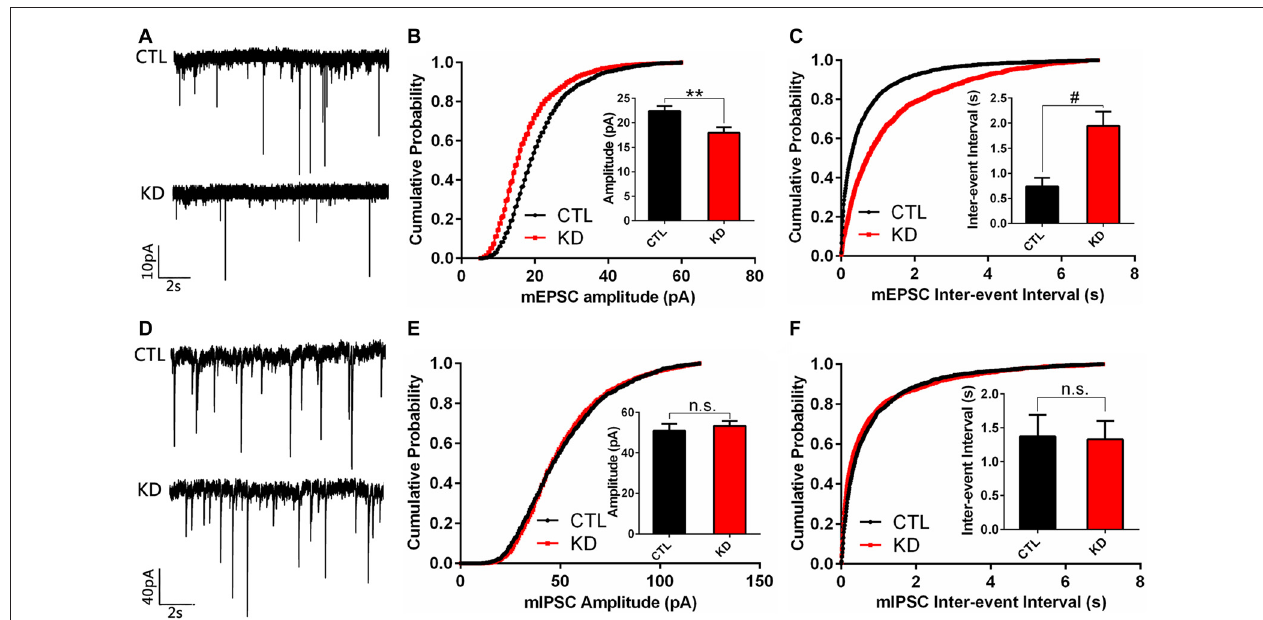
FIGURE 6 | Amplitude and frequency of miniature excitatory post-synaptic current (mEPSC), but not miniature inhibitory post-synaptic current (mIPSC), are reduced in HIP1R-knockeddown neurons. Cultured hippocampal neurons were infected by HIP1R-shRNA or Scrambled lentivirus at DIV6, and whole-cell patch-clamp recording was carried out at DIV13. (A) Example traces of mEPSC. (B) Graph of cumulative probability and bar graph of amplitude mEPSC (HIP1R-KD, 17.93 ± 1.13 pA, n = 19 vs. the control, 22.38 ± 1.03 pA, n = 22) and (C) Graph of cumulative probability and bar graph of inter-event interval of mEPSC (HIP1R-KD, 1.95 ± 0.28 s, n = 19 vs. the control, 0.74 ± 0.17 s, n = 22) showed a significant reduction in mEPSC amplitude and frequency in HIP1R-KD neurons compared to the control. (D) Example traces of mIPSC. (E) Graph of cumulative probability and bar graph of amplitude mIPSC (HIP1R-KD, 53.33 ± 2.32 pA, n = 25 vs. the control, 50.98 ± 3.36 pA, n = 21), and (F) graph of cumulative probability and bar graph of inter-event interval of mIPSC (HIP1R-KD, 1.33 ± 0.27 s, n = 25 vs. the control, 1.37 ± 0.31 s, n = 21) did not show marked differences in mIPSC amplitude and frequency between the two groups. All data are presented as mean ± SEM, unpaired two-tailed t -test. ∗∗ P < 0.01, # P <